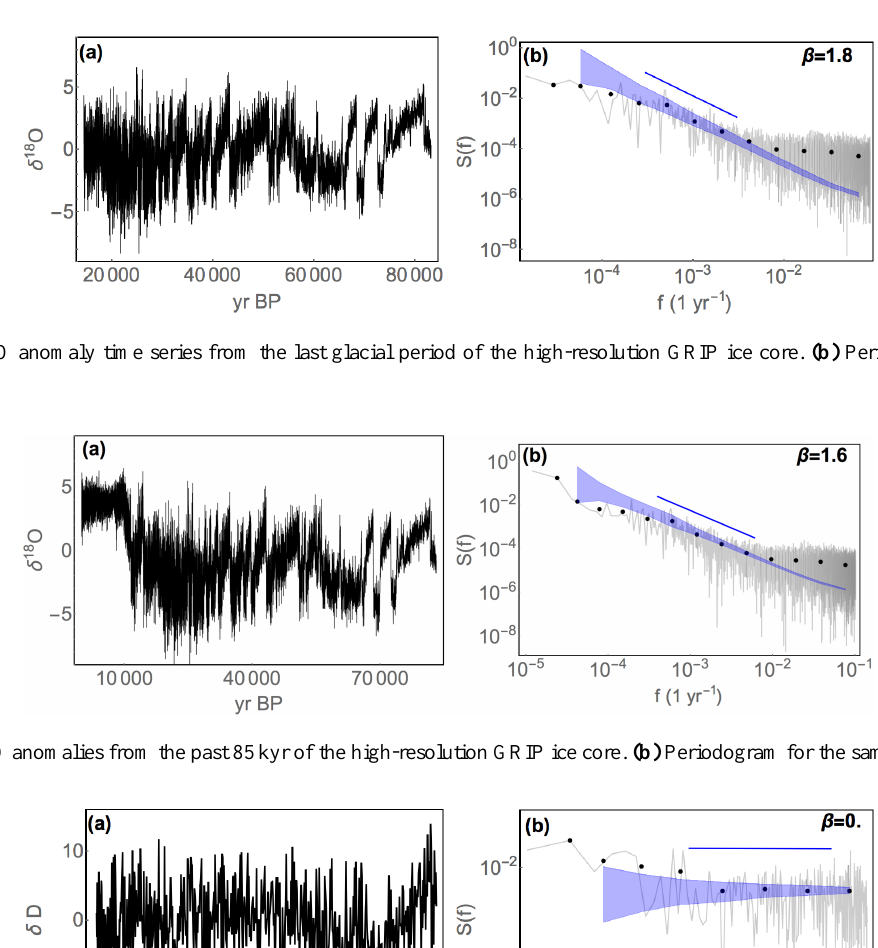
seen at the longest timescales in the GRIP periodogram can be attributed to the 8.2 kyr